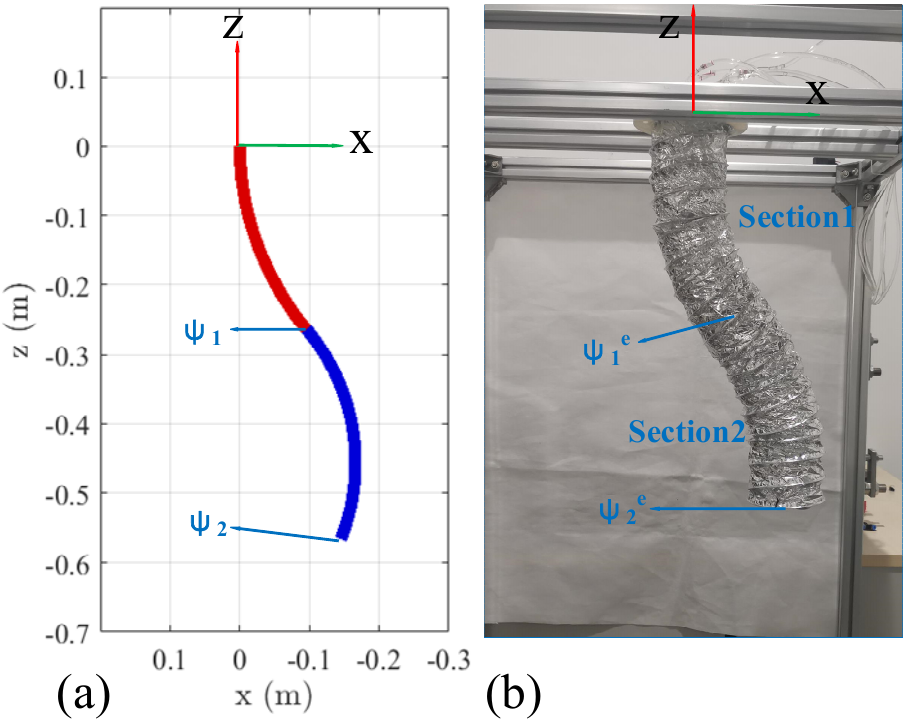
Figure 12. Final pose comparison of the dynamic model and prototype continuum arm for in plane bending of all sections. ( a ) The final posture of the soft manipulator simulation model. ( b ) The final posture of the prototype continuous arm.